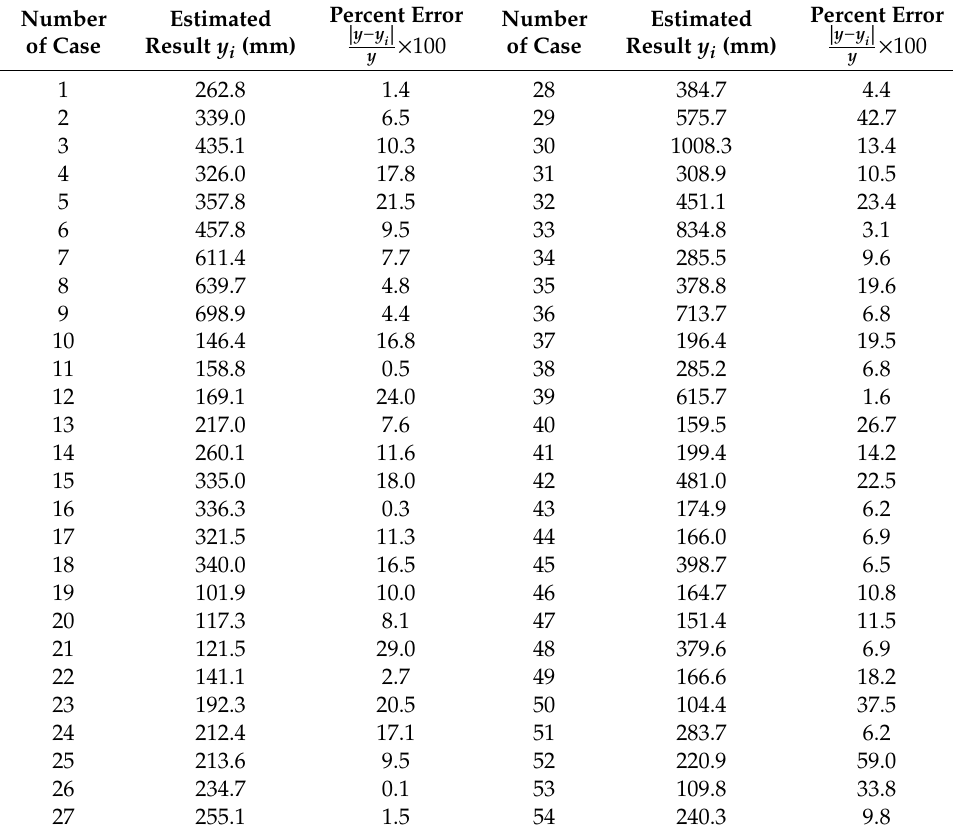
Table 6. Estimated results and percent